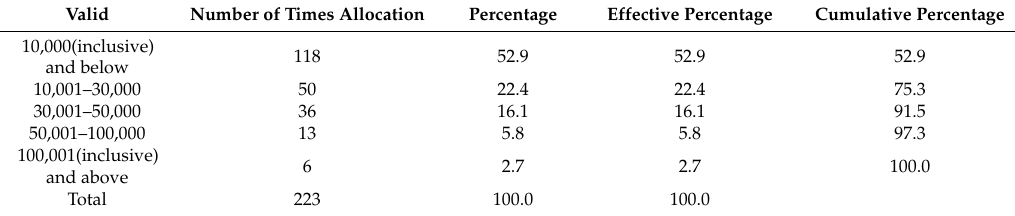
Table 10. Monthly disposable income.